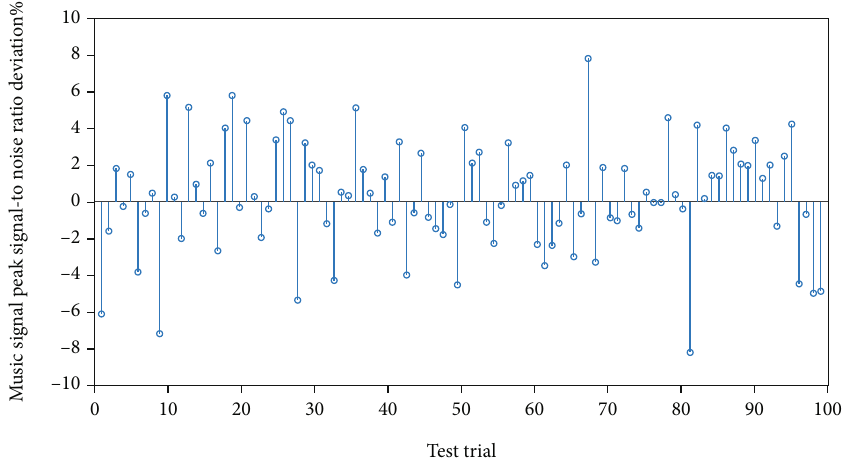
Figure 4: Music signal peak signal-to-noise ratio matchstick graph.